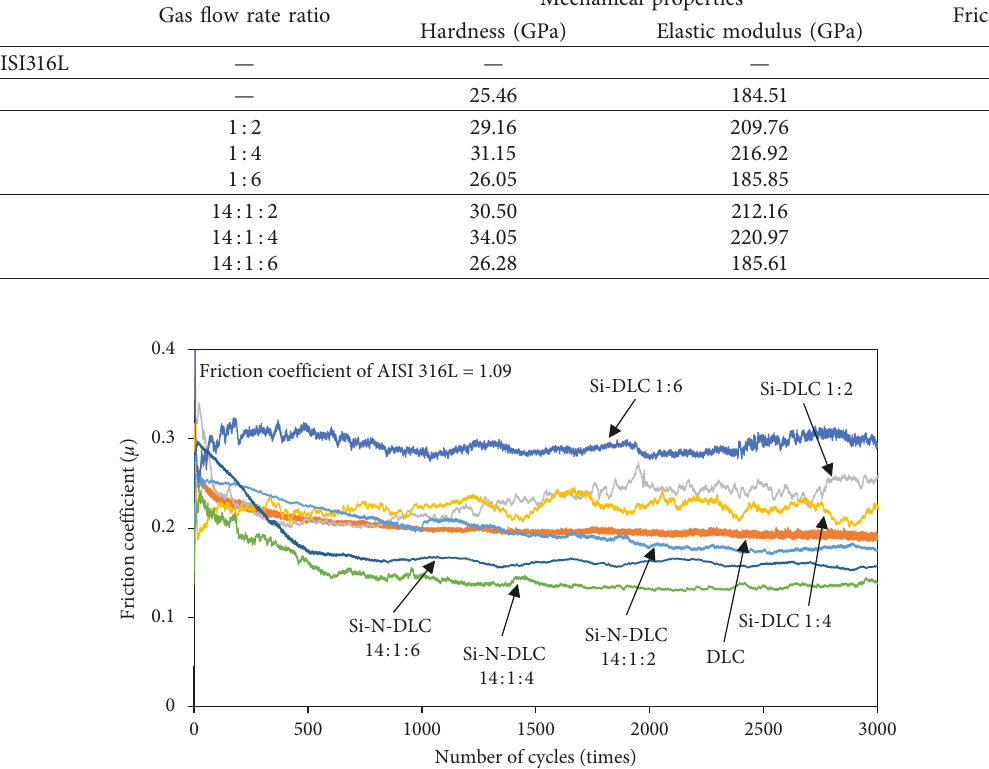
Figure 8: Friction coefficient of pure DLC, Si-DLC, and Si-N-DLC